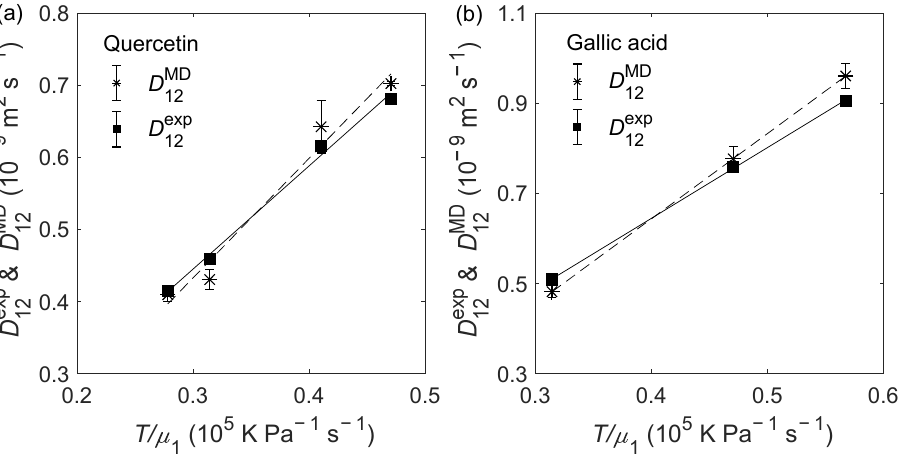
Figure 2. Experimental ( D exp , (cid:4) ) and computed ( D MD , *) diffusion coefficients in liquid ethanol 12 12 versus Stokes–Einstein abscissae ( T / µ 1 ): ( a ) quercetin, and ( b ) gallic acid. The viscosity values were estimated by the Mamedov equation, as proposed by Cano-Gómez et al. [44] .